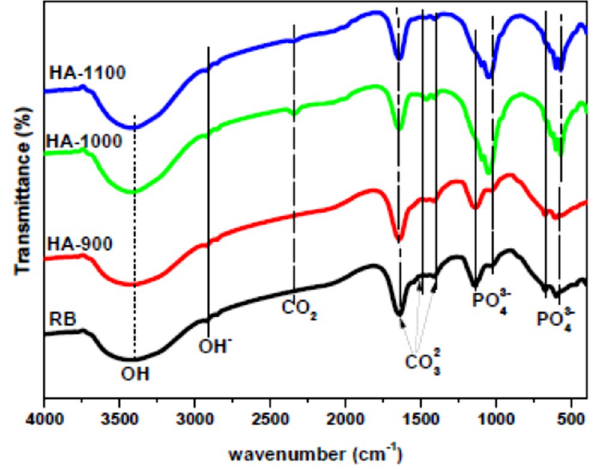
Fig. 14 FTIR of HAp at different temperatures